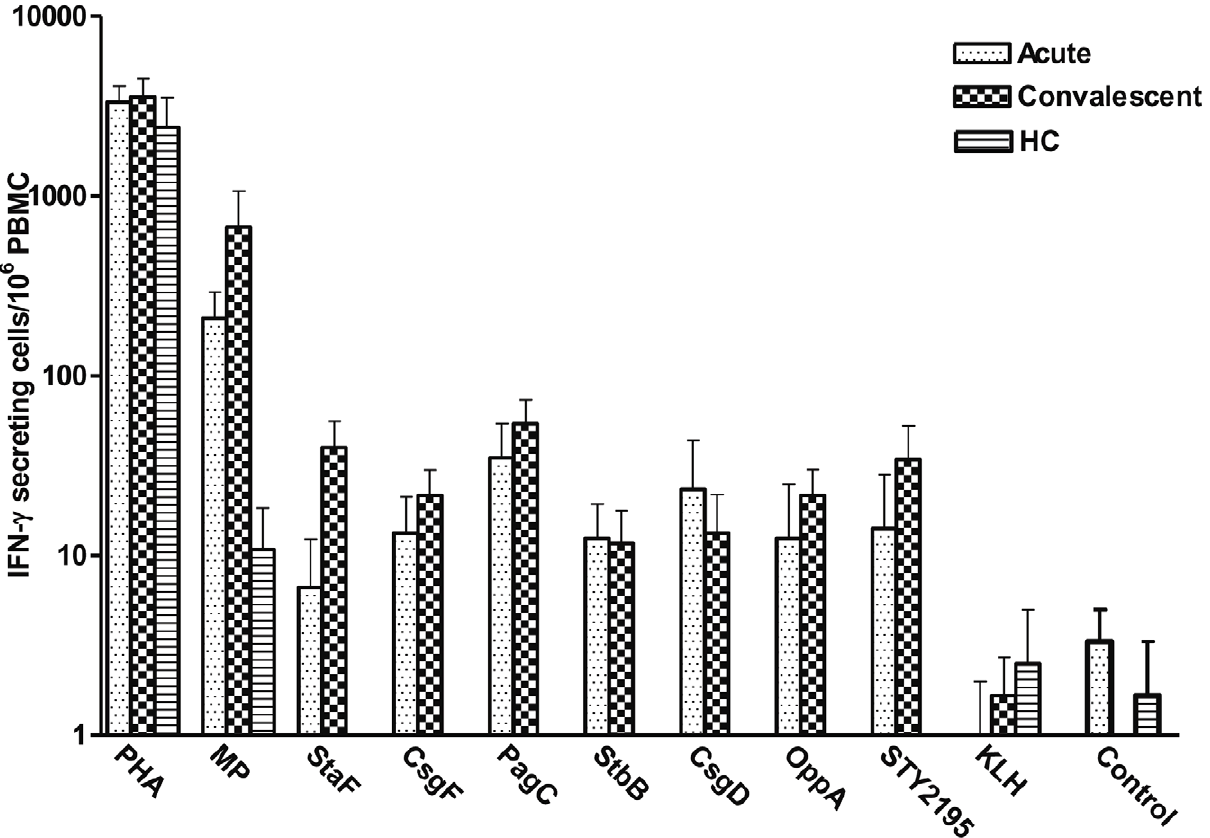
Figure 1. Interferon- c ELISPOT responses to S . Typhi antigens including StaF (STY0202), CsgF (STY1177), PagC (STY1878), StbB (STY0372), CsgD (STY1179), OppA (STY1304), conserved hypothetical protein encoded by STY2195, S . Typhi membrane preparation (MP), control protein, and phytohaemagglutinin (PHA) and keyhole limpet hemocyanin (KLH) during acute and convalescent stage illness in S . Typhi bacteremic patients and in healthy controls (HC). Mean and standard error of the mean represented.